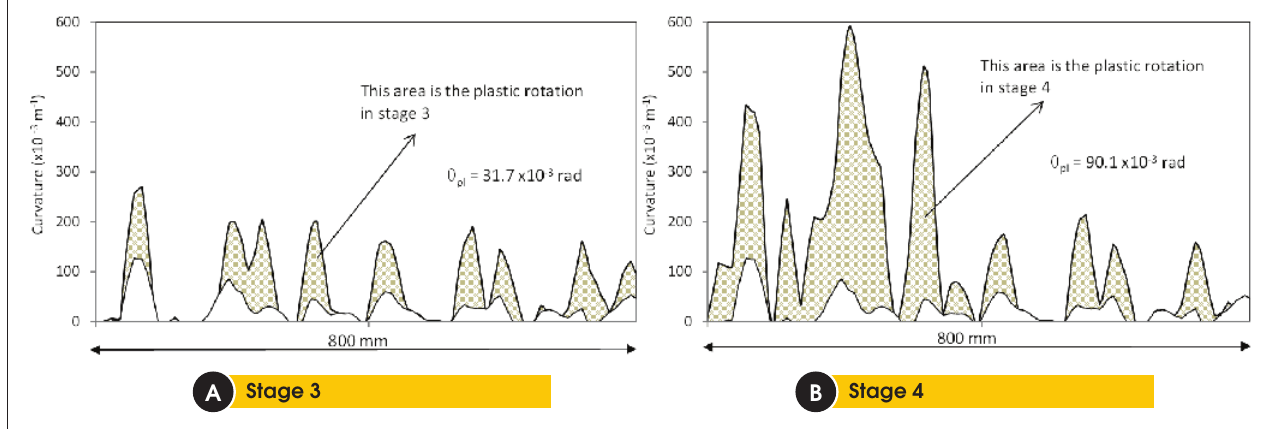
Figure 12 – Plastic rotation using method 1 with shaded area representing the plastic rotation